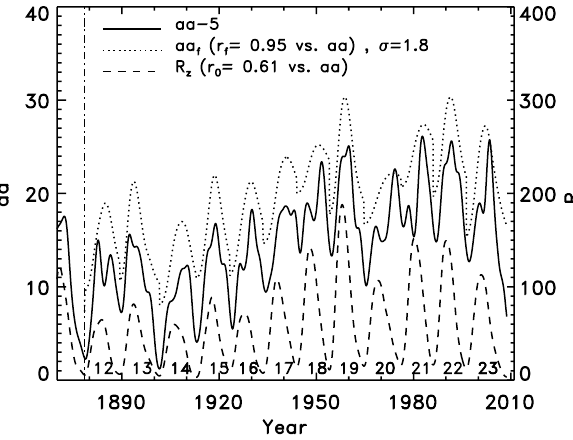
Fig. 6. Parameters for Cycles n = 12–23: (a) for D (solid) and τ (dotted); (b) for aa 0 − 5 (solid), aa min (dotted), and R max (dashed). (c) The correlation coefficient of aa with R z ( r 0 , solid) and that of aa with aa f ( r f , dotted). The correlations of D with τ , aa 0 , and r 0 are r = − 0 . 41, − 0 . 40, and 0.48, respectively. The correlations of aa 0 with aa min and R max are r = 0 . 95 and 0.89, respectively.